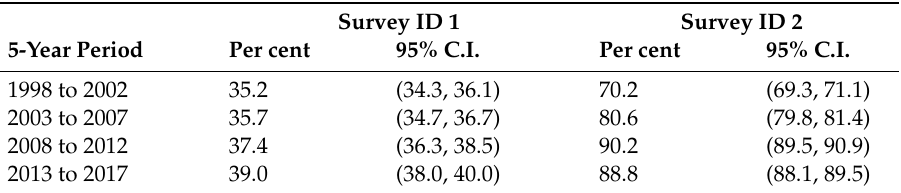
Table A6. Average Percentage of houses with Critical Healthy Living Priorities fully met at Survey-Fix1 and Survey–Fix 2 for all NSW projects 1998-2017 by 5-year intervals.